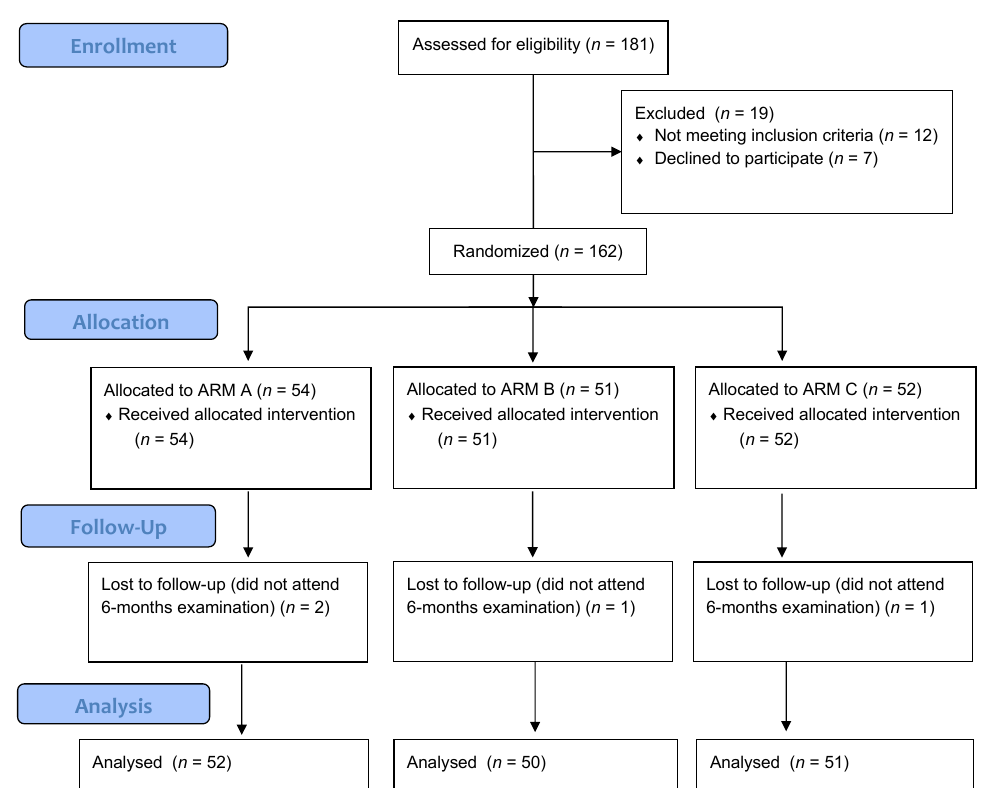
Figure 1. CONSORT Flow diagram for enrollment, allocation, follow-up, and analysis of women included in the trial.